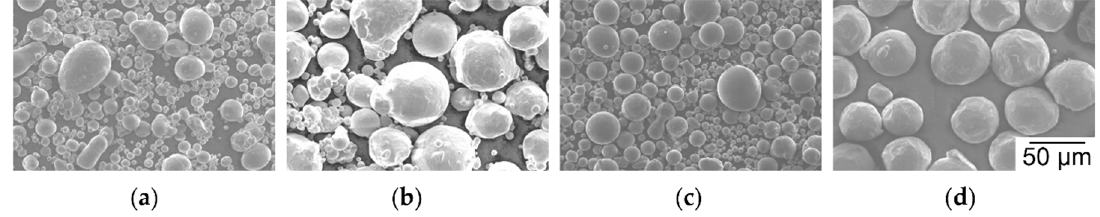
Figure 5. SEM images of spherical powder particles as delivered before sieving; ( a ) N atomized Al; ( b ) N atomized Cu; ( c ) N atomized AlMg50; ( d ) Ar atomized Ti6Al4V.